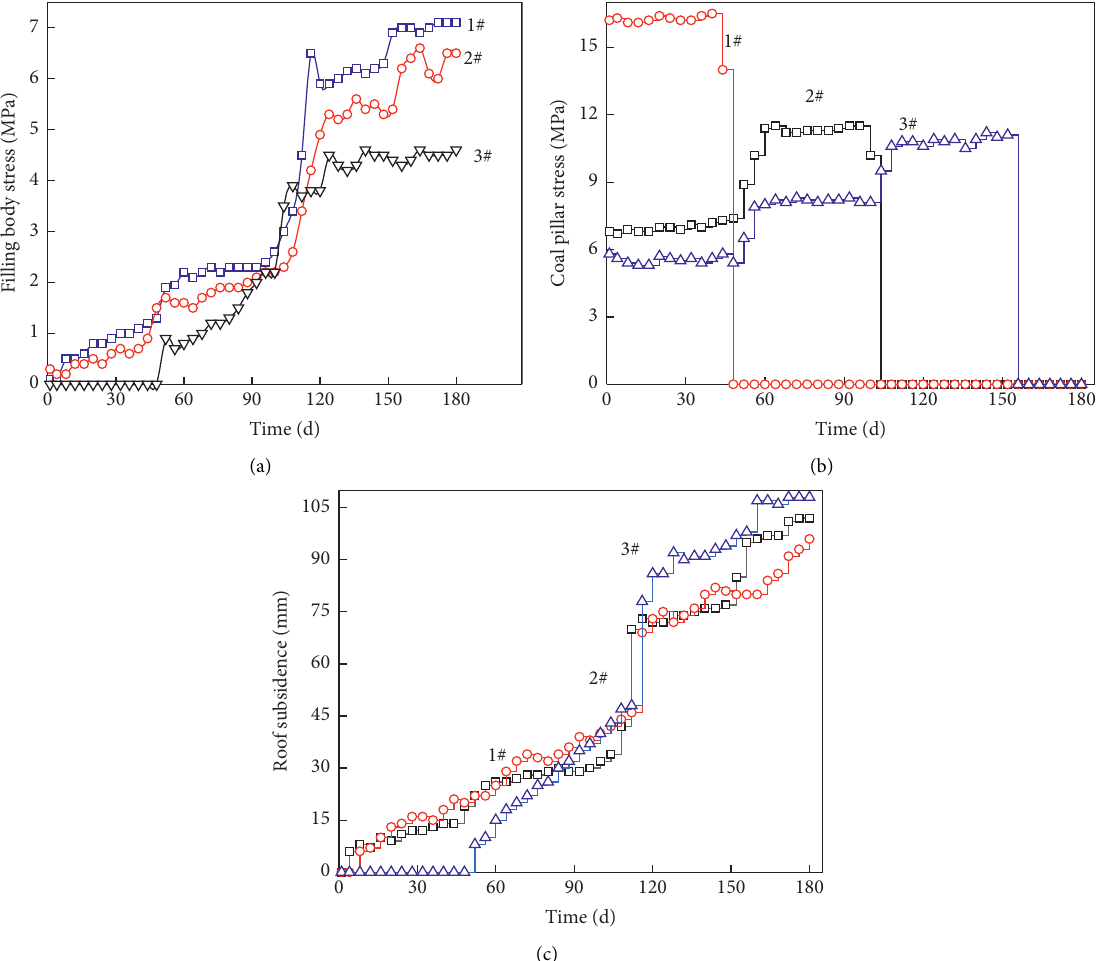
Figure 13: Monitoring data. (a) Backfilling body stress. (b) Coal pillar stress. (c) The amount of roof subsidence.